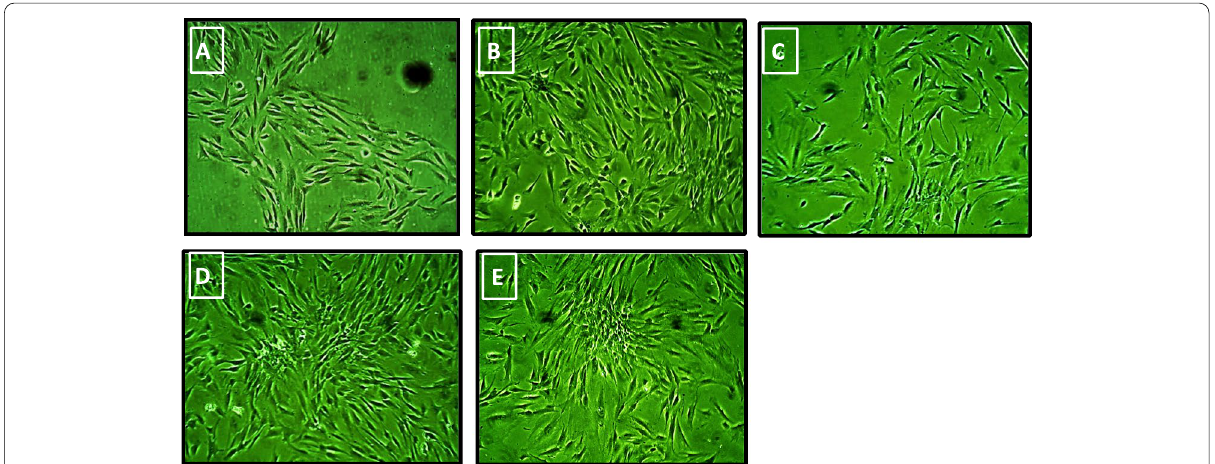
Fig. 1 The proliferation and the morphological characteristics of hDP‑MSCs derived from a 32‑year‑old donor during the expansion phase: hDPMSCs were cultured at different passages. ( A ) Primary culture (P0) on day 7. ( B ) and ( C ) First passage (P1) on days 3 and 7, respectively. ( D ) Second passage (P2) on day 4. ( E ) Third passage (P3) on day 5